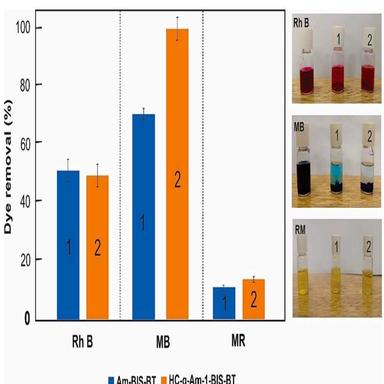
Dye removal percentage of MB, Rh B, and RM dyes by HC-g-Am-1-BIS-BT and Am-BIS-BT hydrogels.